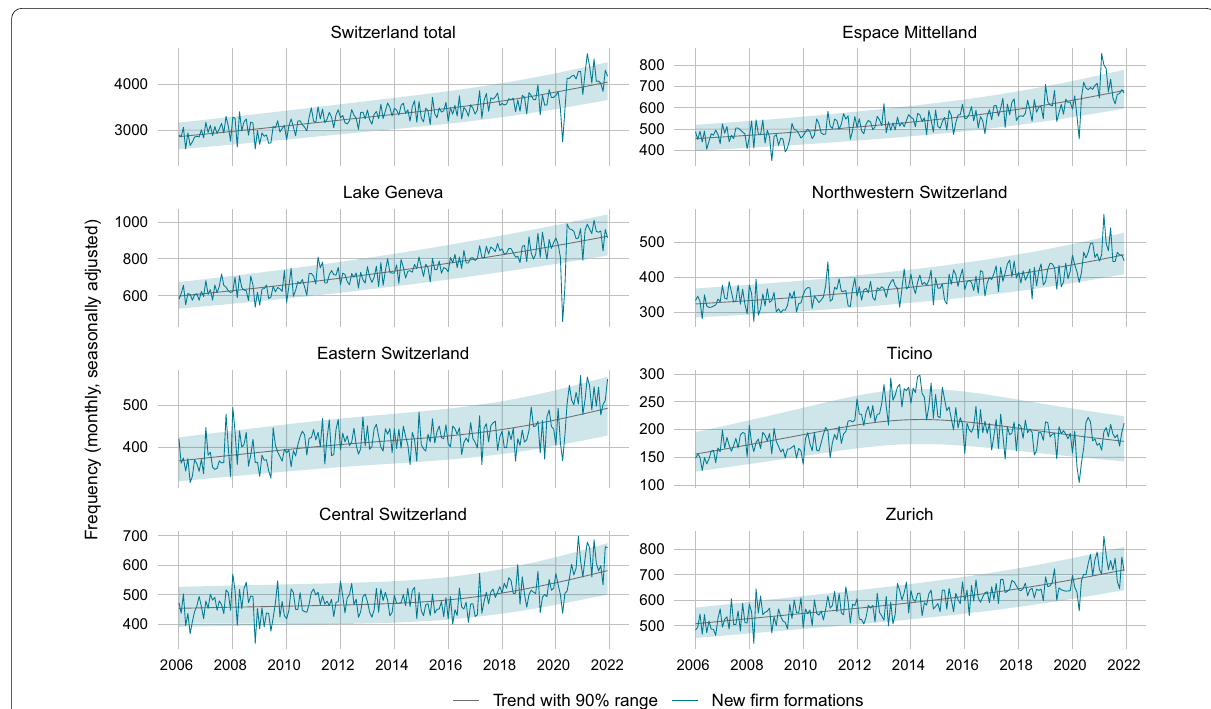
Fig. 22 Monthly frequency of firm start-ups at the regional level. Notes : The figure shows the monthly seasonally adjusted frequency of new firm formations in the Swiss greater regions excluding SCO Art. 731b cases, together with a trend and the 90% probability